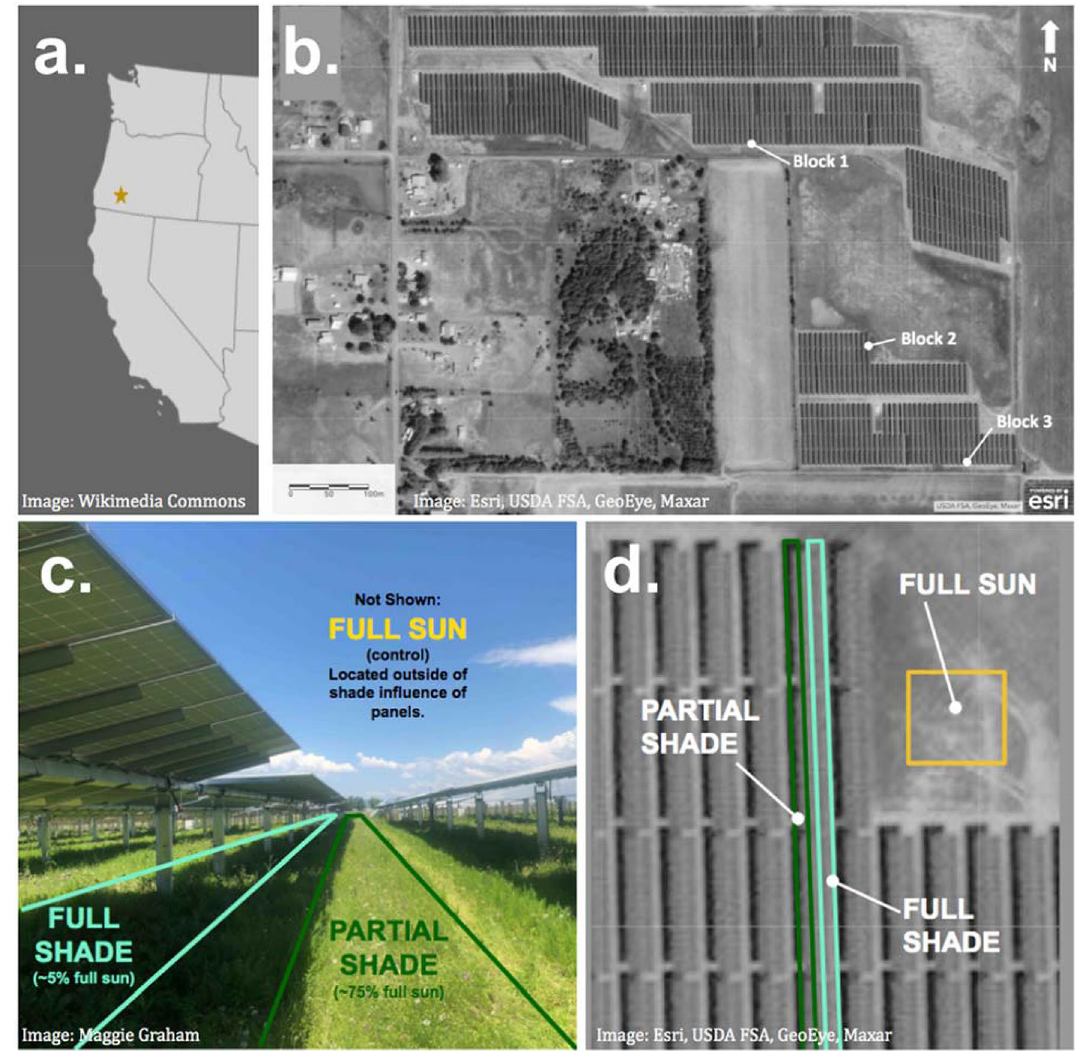
Figure 1. Site location and experimental design. The Eagle Point Solar Plant is ( a ) located in southern Oregon’s Rogue Valley. We established ( b ) three replicates within the site, each with three treatments (full sun as yellow, partial shade as green, full shade as blue), as shown in the ( c ) side view and ( d ) aerial view. Base imagery sources: ( a ) Wikimedia Commons 2019, ( b , d ) Esri 2021, USDA FSA, GeoEye,